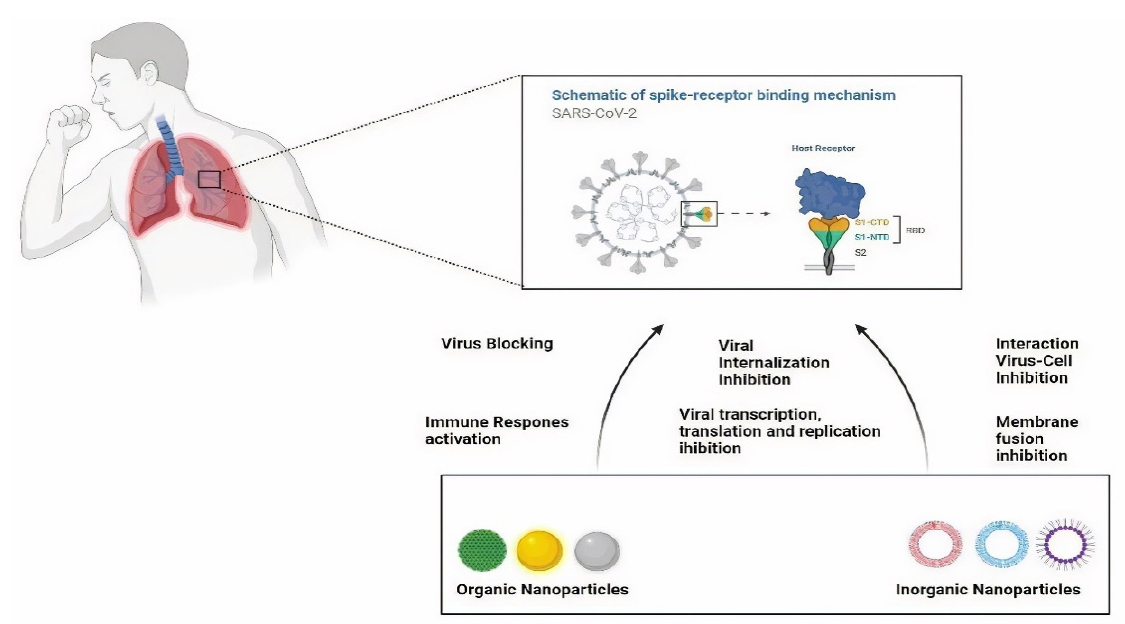
Figure 4. Types of nanoparticles for SARS-CoV-2